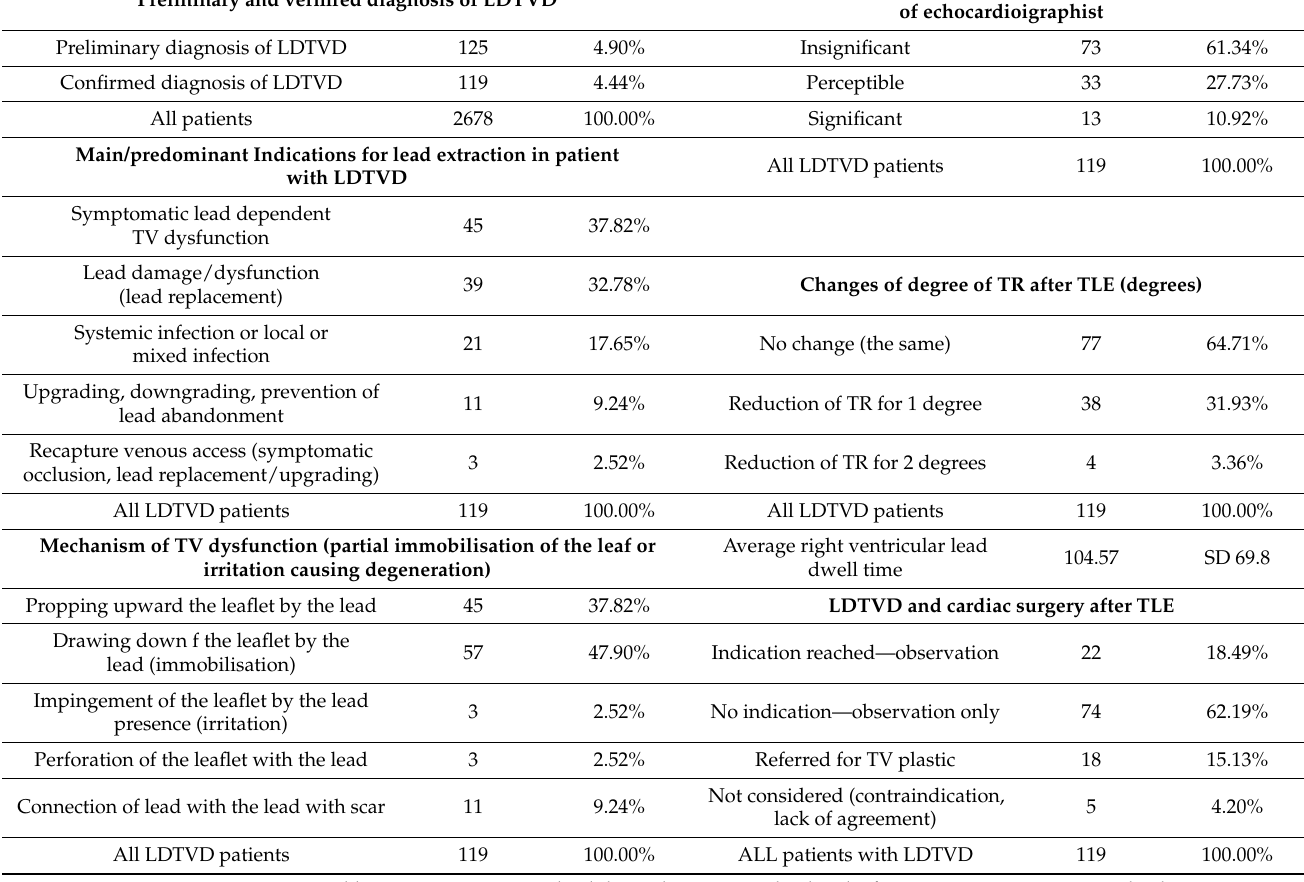
Table 1. Basic information about 119 patients with confirmed